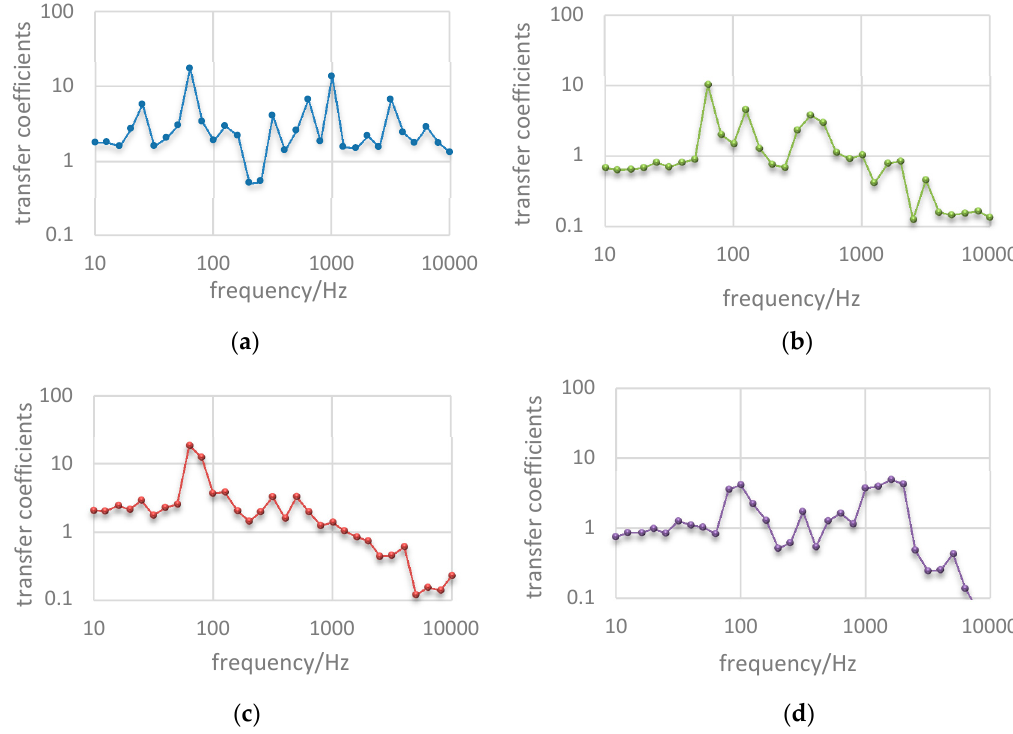
Figure 9. Test results under 1710 r/min: ( a ) single layer metal bellows (SLMB); ( b ) DLMB; ( c ) BCR and ( d ) RP.